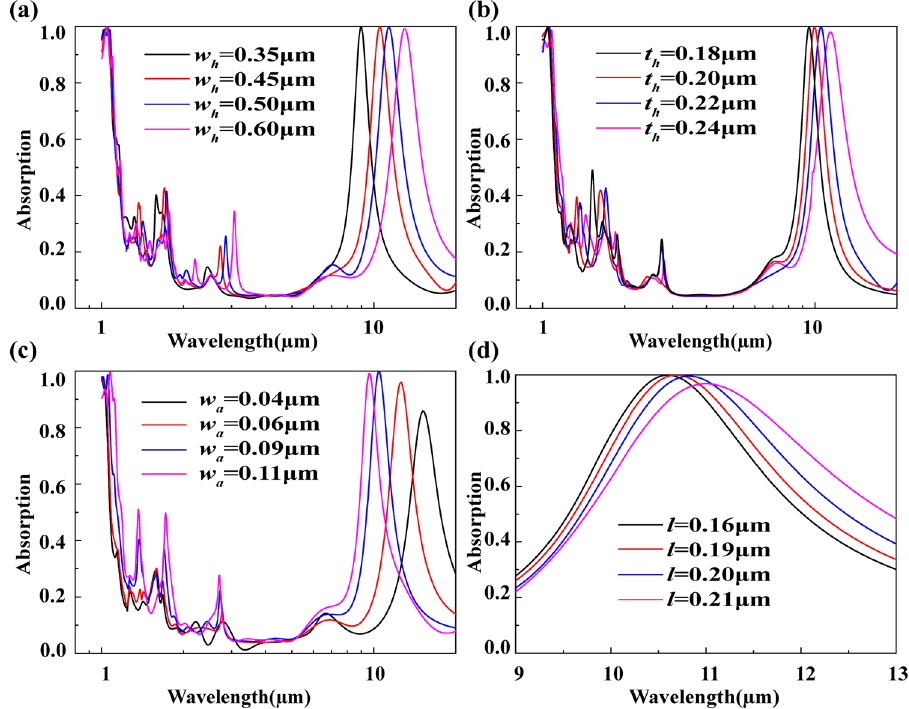
Figure 6. Absorption spectrum of the proposed absorber for different structure parameters. ( a ) Cavity width. ( b ) Cavity height. ( c ) Slit width. ( d ) Gold ring